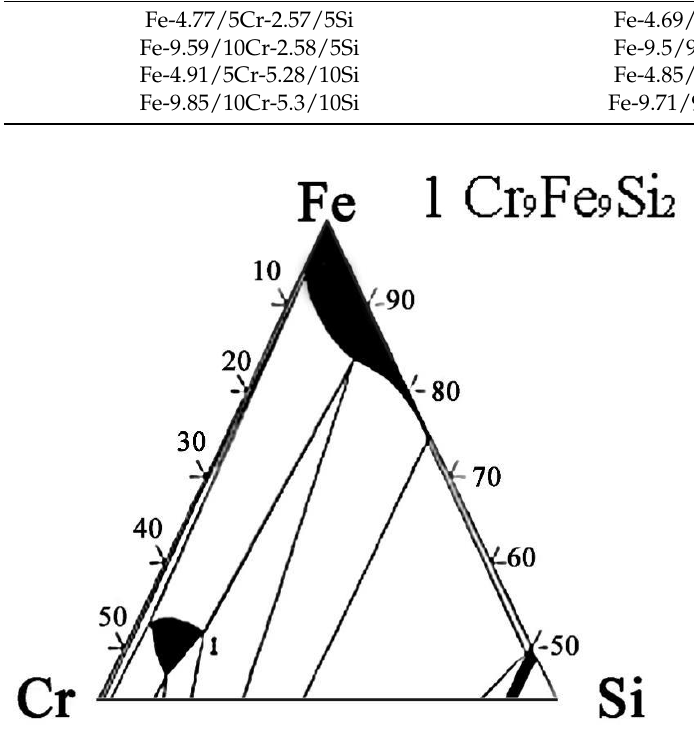
Figure 1. Ternary phase diagram of Fe-Cr-Si alloy system at 427 °C (Fe-rich corner).